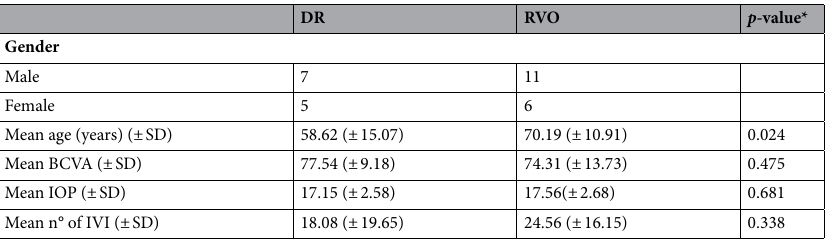
Table 1. Patient demographics of study cohort at baseline. DR diabetic retinopathy, RVO retinal vein occlusion, SD standard deviation, BCVA best corrected visual acuity, n° number, IOP intraocular pressure, IVI intravitreal injection. *t-test comparing means of both subgroups.